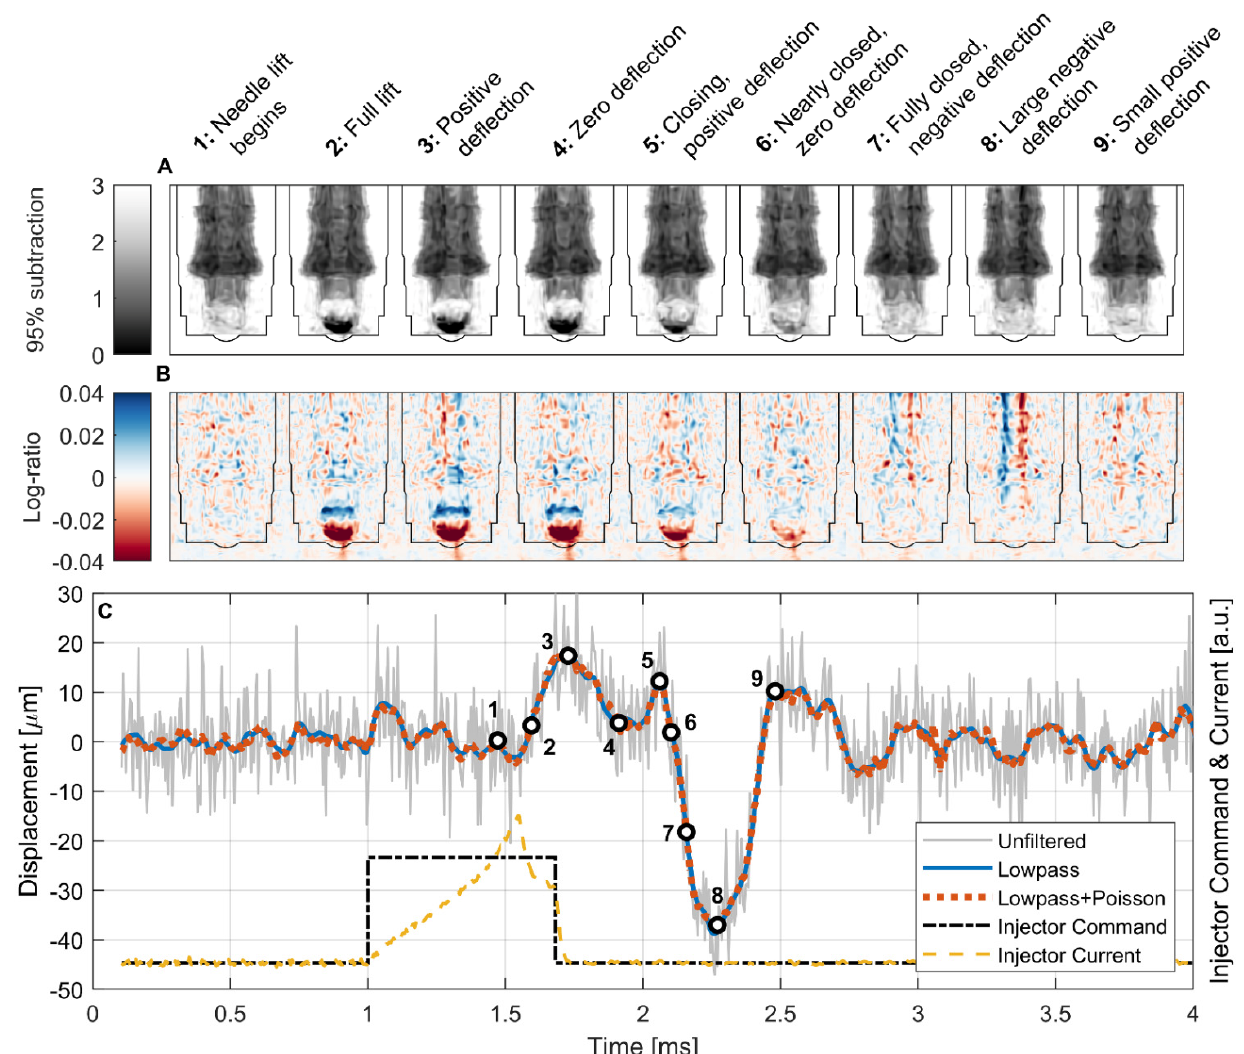
Figure 9. Results of high-speed imaging measurements and displacement model fitting. Selected frames from the 95% subtraction ( A ) and log-ratio ( B ) normalizations with lowpass + Poisson filtering highlighting motion of the injector needle. The injector body outline has been overlaid on the normalized images for clarity. ( C ) Time-series fits of needle displacement indicate sub-pixel resolution relative to the 55 μ m pixel size with significant noise reduction for the filtered cases but similar shape and magnitude to the unfiltered case.